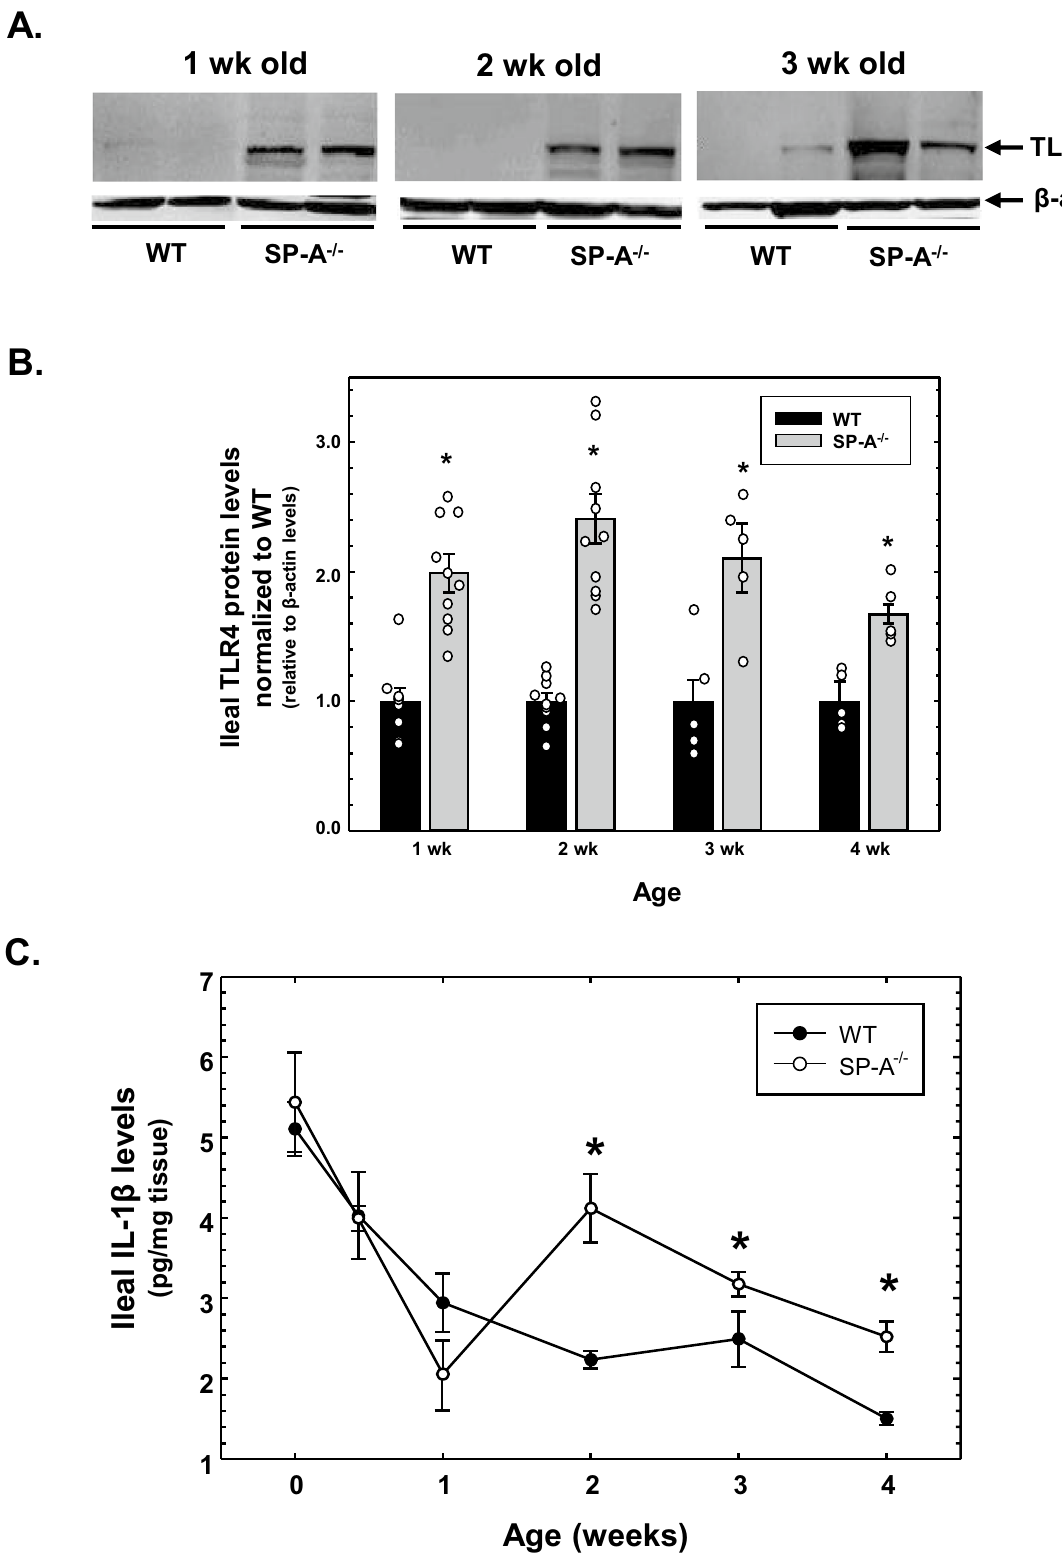
Figure 1. Expression of TLR4 and IL-1β protein in the ileum of SP-A-deficient infant mice compared to wild type infant mice. ( A ) Detection of TLR4 and β-actin protein in the ileum of SP-A-deficient (SP-A −/− ) and wild type (WT) mouse pups of various ages was accomplished by Western analysis. ( B ) Graphical representation of ileal TLR4 levels in SP-A −/− mice normalized to WT mice at various ages. Shown are the results of WT and SP-A −/− mice for each age (n ≥ 6 from ≥ 2 litters). ( C ) Ileal IL-1β levels, determined by ELISA and expressed as pg per mg ileal protein, in SP-A −/− mice compared to WT as a function of age (n ≥ 6 from ≥ 2 litters). * indicates P < 0.05. Figure created using SigmaPlot, ver 14, www.systa tsoft